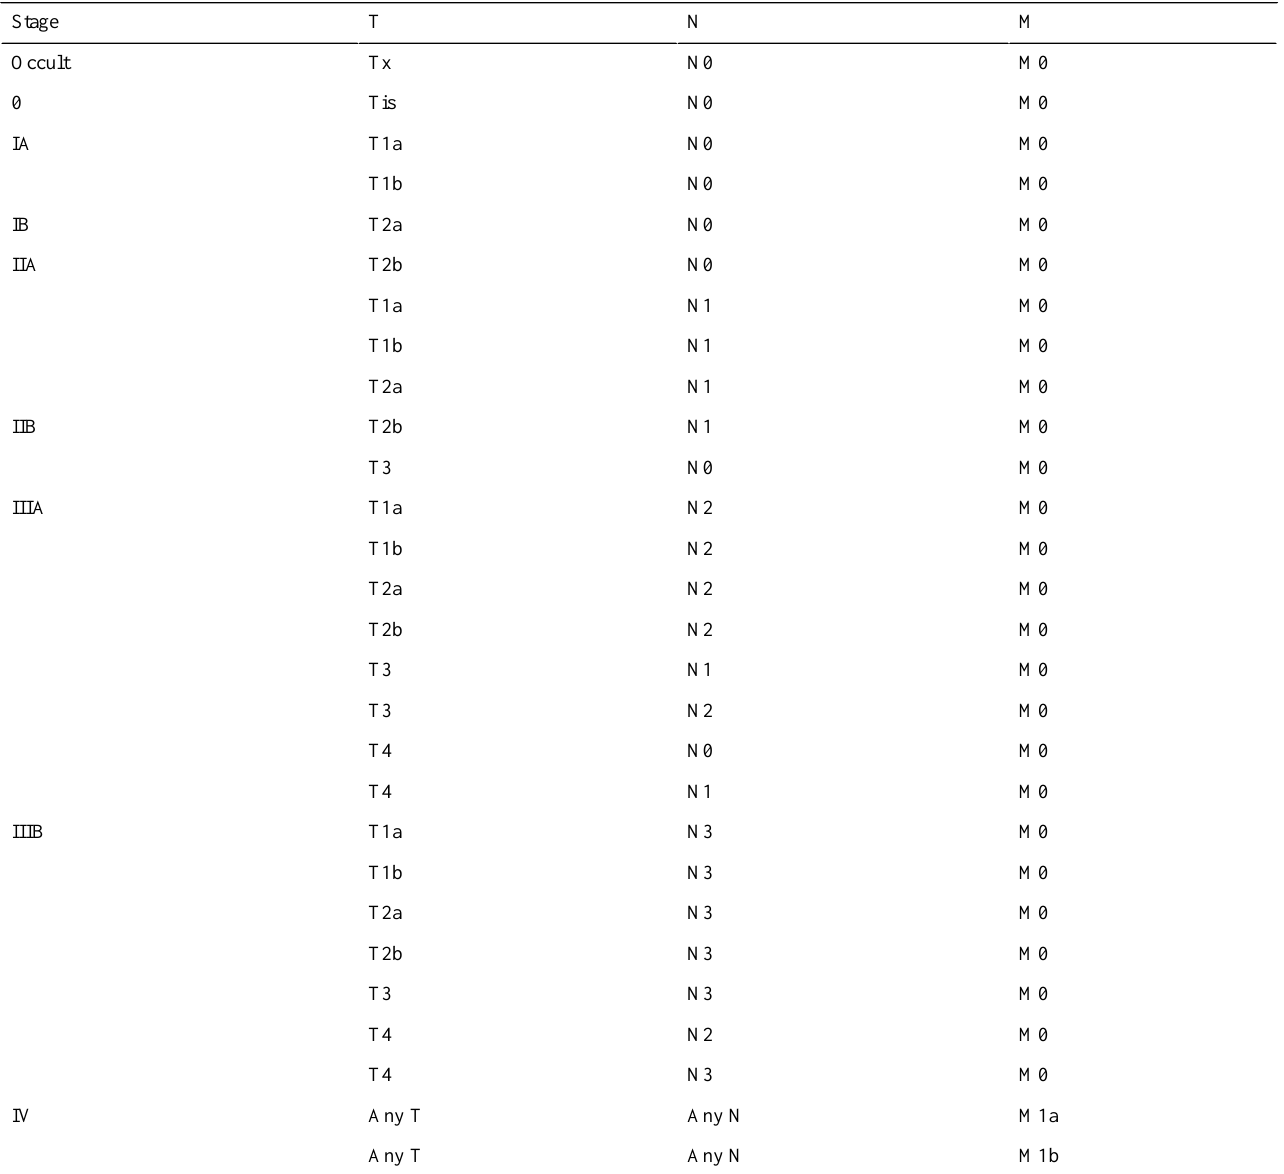
Table 2. Anatomic stage/prognostic groups for cancer of the lung. MNTStage M0N0TxOccult M0N0Tis0 M0N0T1aIA M0N0T1b M0N0T2aIB M0N0T2bIIA M0N1T1a